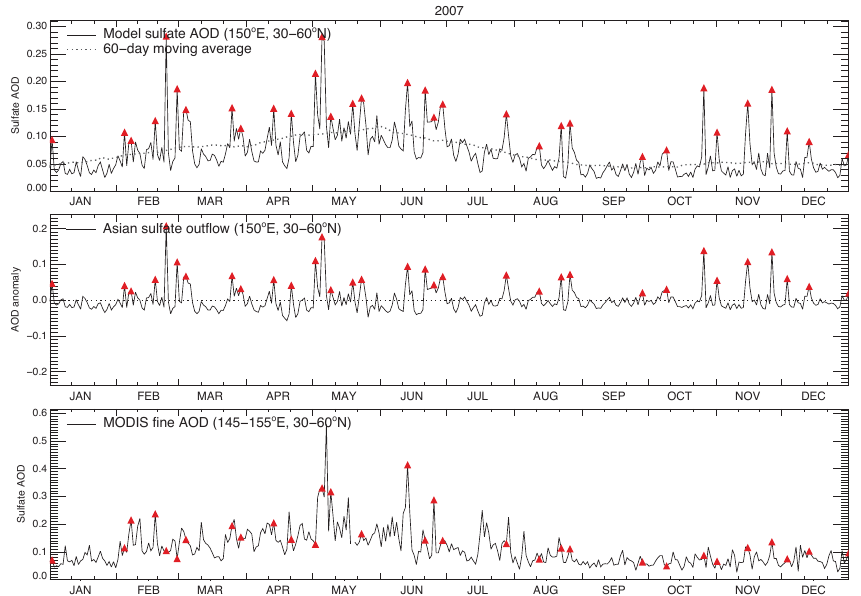
Fig. 3. Top: Daily GEOS-Chem sulfate AOD averaged in the Asian outflow region (30–60 ◦ N, 150 ◦ E, black solid line) for the year 2005. The dashed line indicates the 60-day running mean. Middle: Sulfate AOD anomalies “Asian outflow timeseries” (timeseries on top panel minus the 60-day running mean). Bottom: Daily MODIS fine AOD at 30–60 ◦ N, 145–155 ◦ E for 2007. Red triangles indicate the 33 enhanced Asian export LRT + days identified using the GEOS-Chem “Asian outflow timeseries”, as described in Sect.